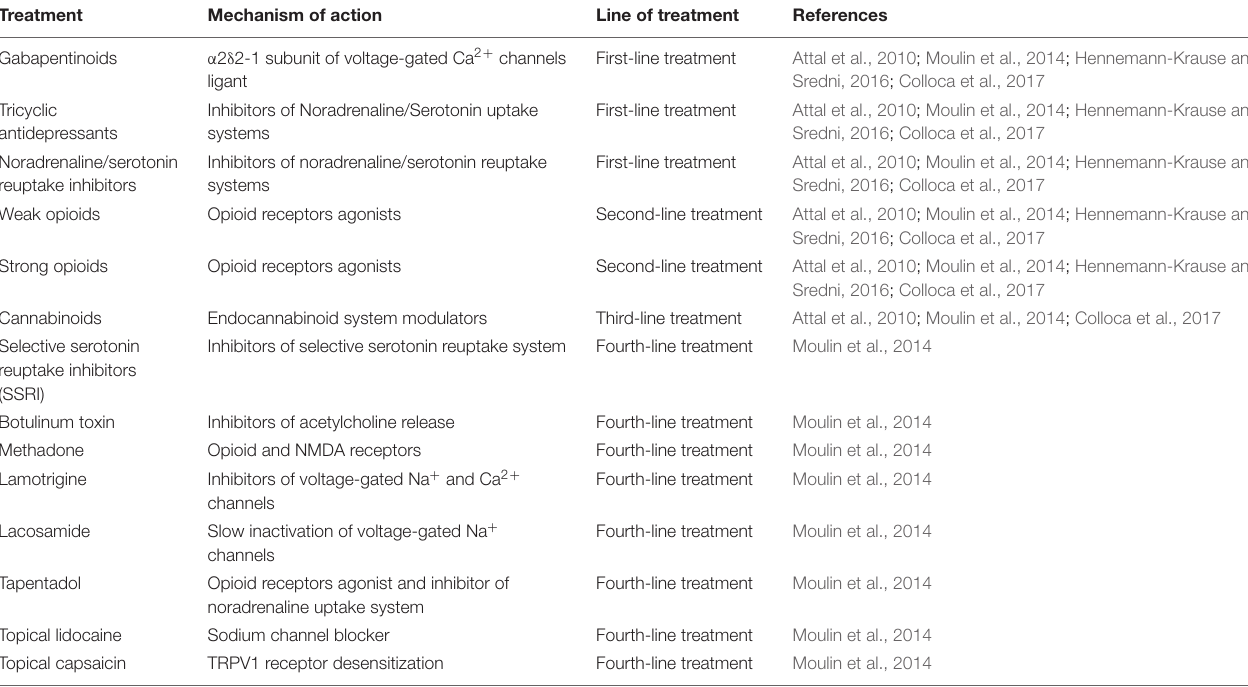
TABLE 1 | The four lines of treatment for chronic neuropathic